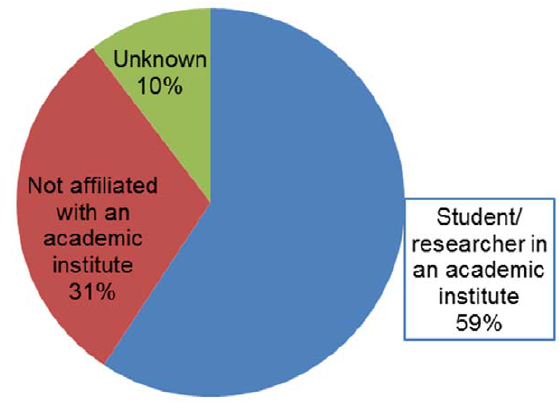
Figure 5. Affiliation with an academic institute.